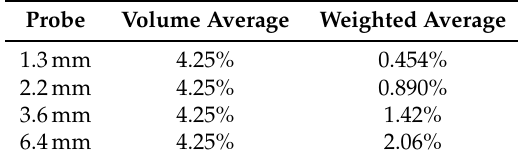
Table 5. Mean percentage errors between permittivities measured in simulations and predictions from either volume averaging or ˆ E 2 -weighted averaging of the permittivity distribution.